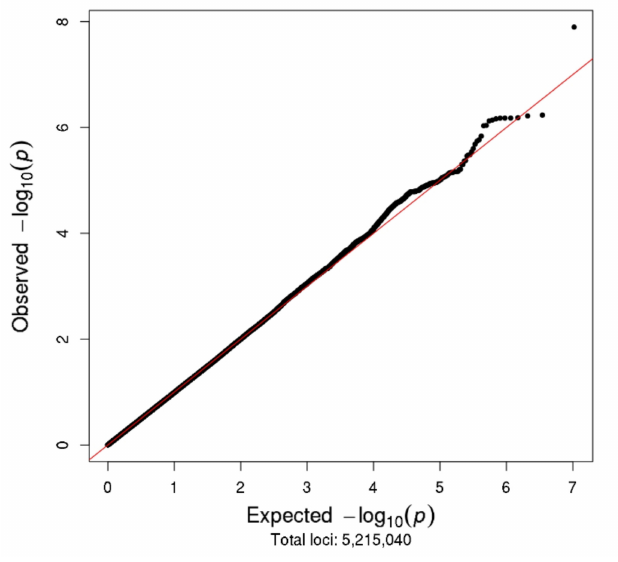
Figure 5. Q–Q plot for the MCBDR